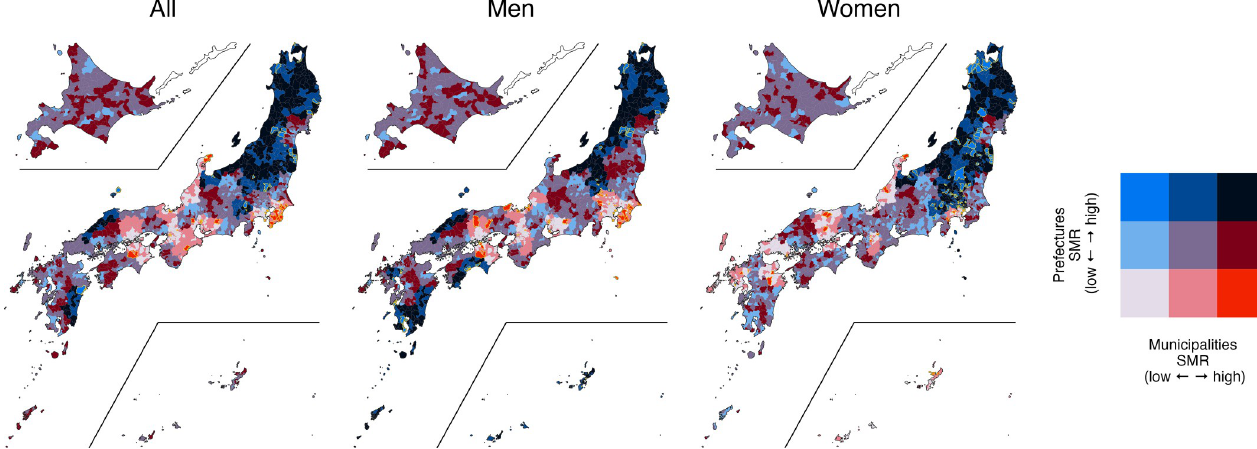
Fig 3. Bivariate map between municipalities and prefectures. SMR: standardized mortality ratio; geographic distribution was visualized based on the tertiles of each region. The following map data (CC BY 4.0) was processed and used: Ministry of Land, Infrastructure, Transport and Tourism. National surveys of Japan—Administrative area data (in Japanese). 2019. Available from: https://nlftp.mlit.go.jp/ksj/gml/datalist/KsjTmplt-N03-v3_0.html.